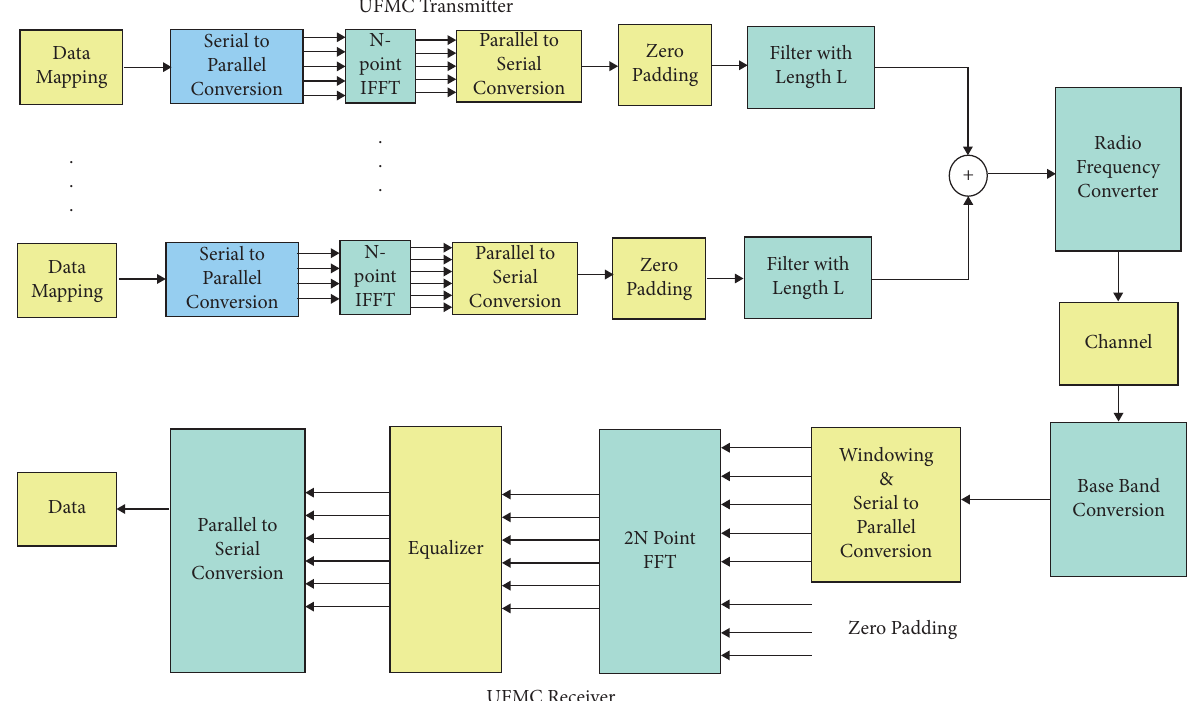
Figure 4: Universal flter multicarrier